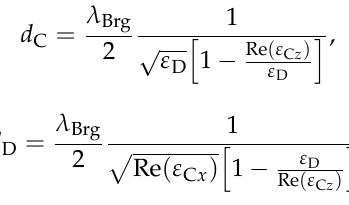
Figure 6. ( a ) Absorptance and ( b ) group refractive index spectra of the designed 1-D PCCH [(EF) 2 D] 6 at different incident angles 0° , 30° , and 60° under TM polarization. ( c ) Absorptance spectrum of the designed 1-D PCCH [(EF) 2 D] 6 as a function of the incident angle under TM polarization.